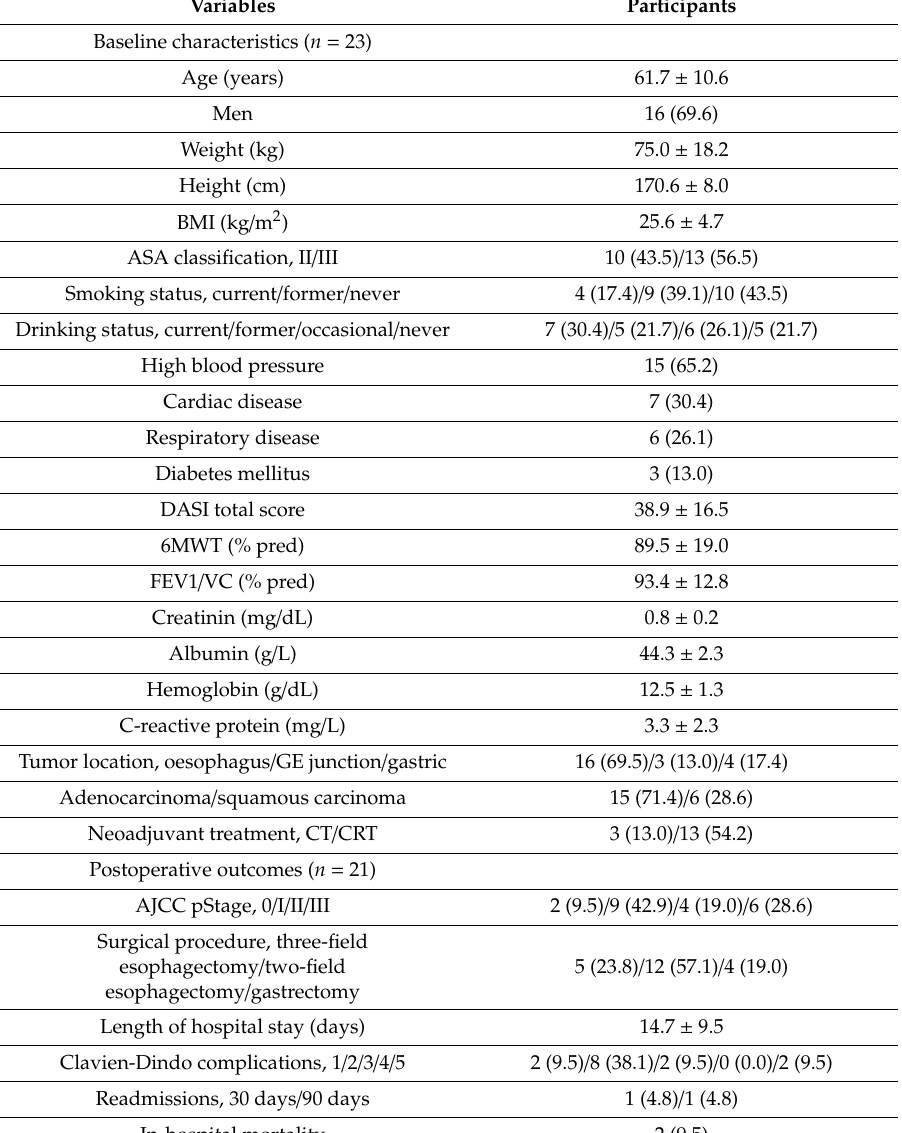
Table 2. Participant